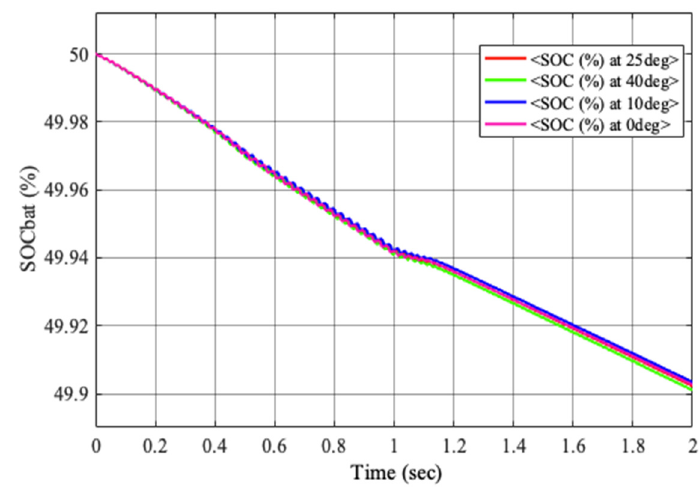
Figure 14. 𝑆𝑂𝐶 (cid:3029)(cid:3028)(cid:3047) in a PV system without a